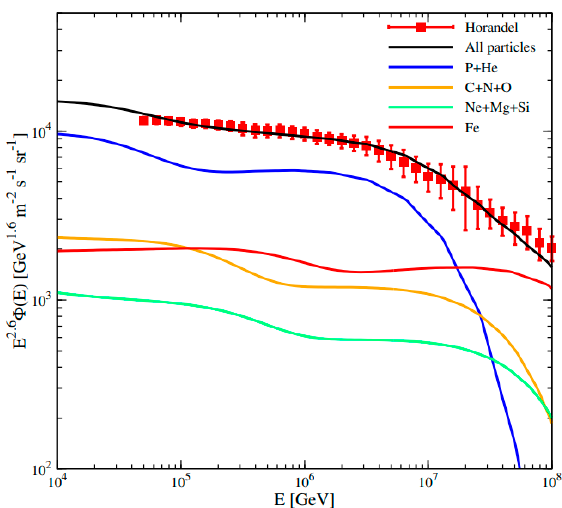
Figure 3. The all-particle spectra multiplied by E 2.6 . The data points are taken from [88]. The solid lines with different colors are the model predictions for different mass groups, and the black solid line is the total contribution.